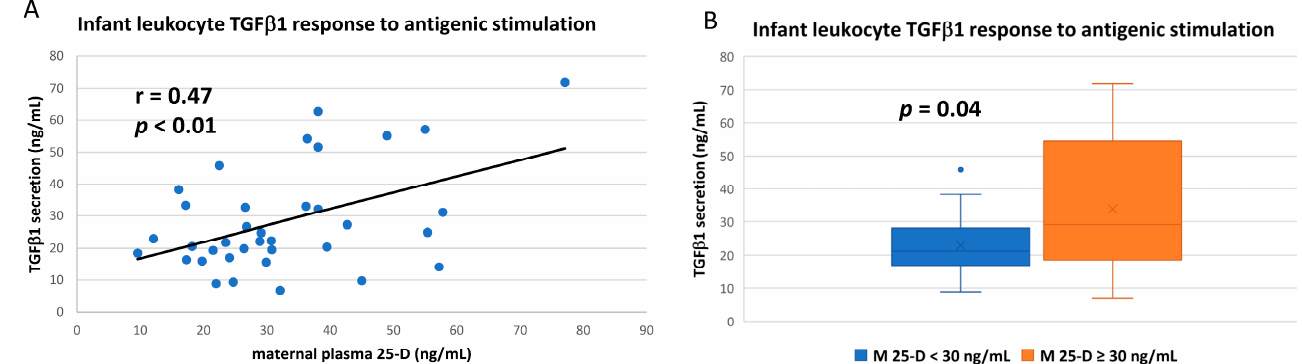
Figure 5. TGF β 1 responses of infant leukocytes to in vitro antigenic stimulation. Whole blood from breastfeeding infants was antigen-stimulated and culture supernatants analyzed for TGF β 1 content.